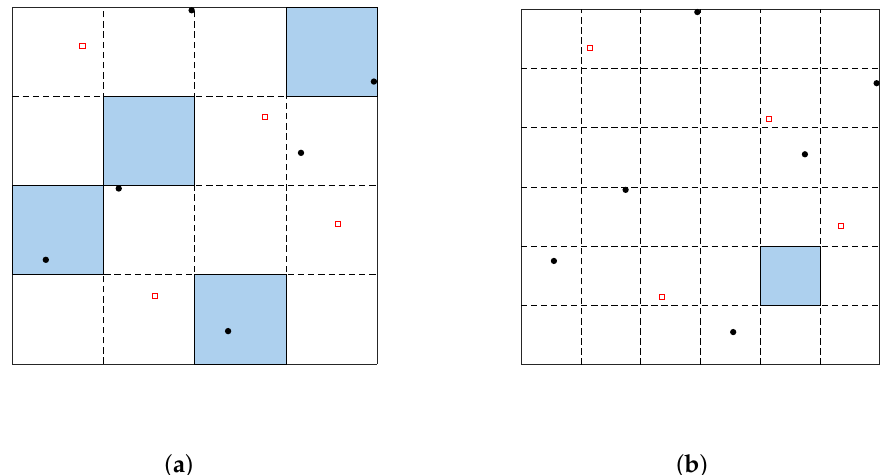
Figure 4. A resulting design with design points spread out. ( a ) the n design points fall into different cells in the 4 × 4 grid; ( b ) the n design points fall into different cells in the 6 × 6